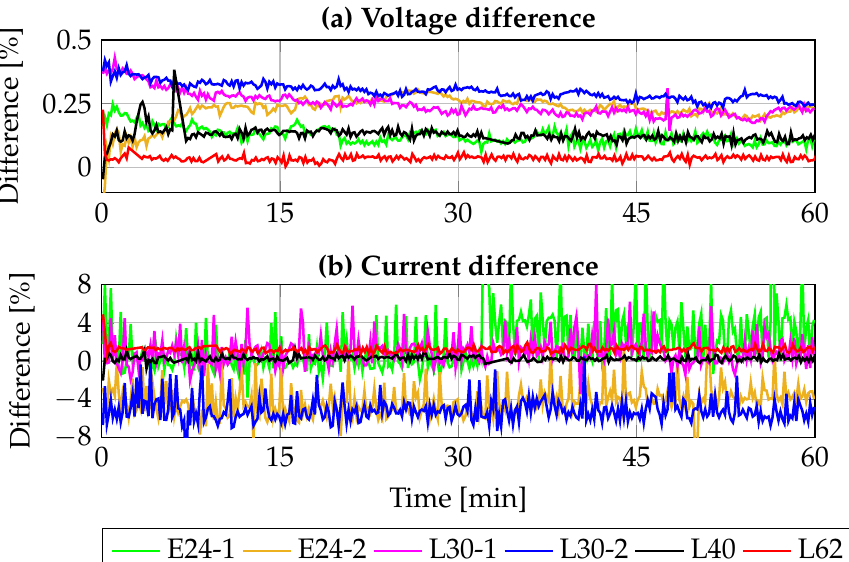
Figure 7. Comparison of voltage and current difference measured between EE and BMSs datasets. Subplot ( a ) shows the percentage voltage difference whereas ( b ) the percentage current difference.